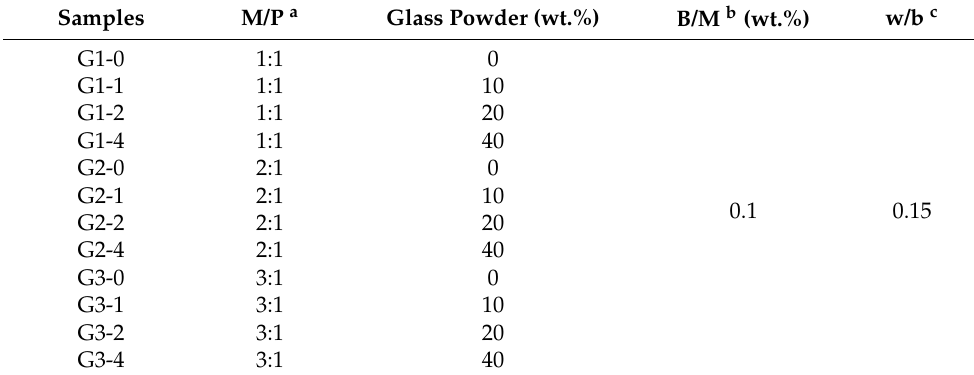
Table 2. Mix proportion design of the